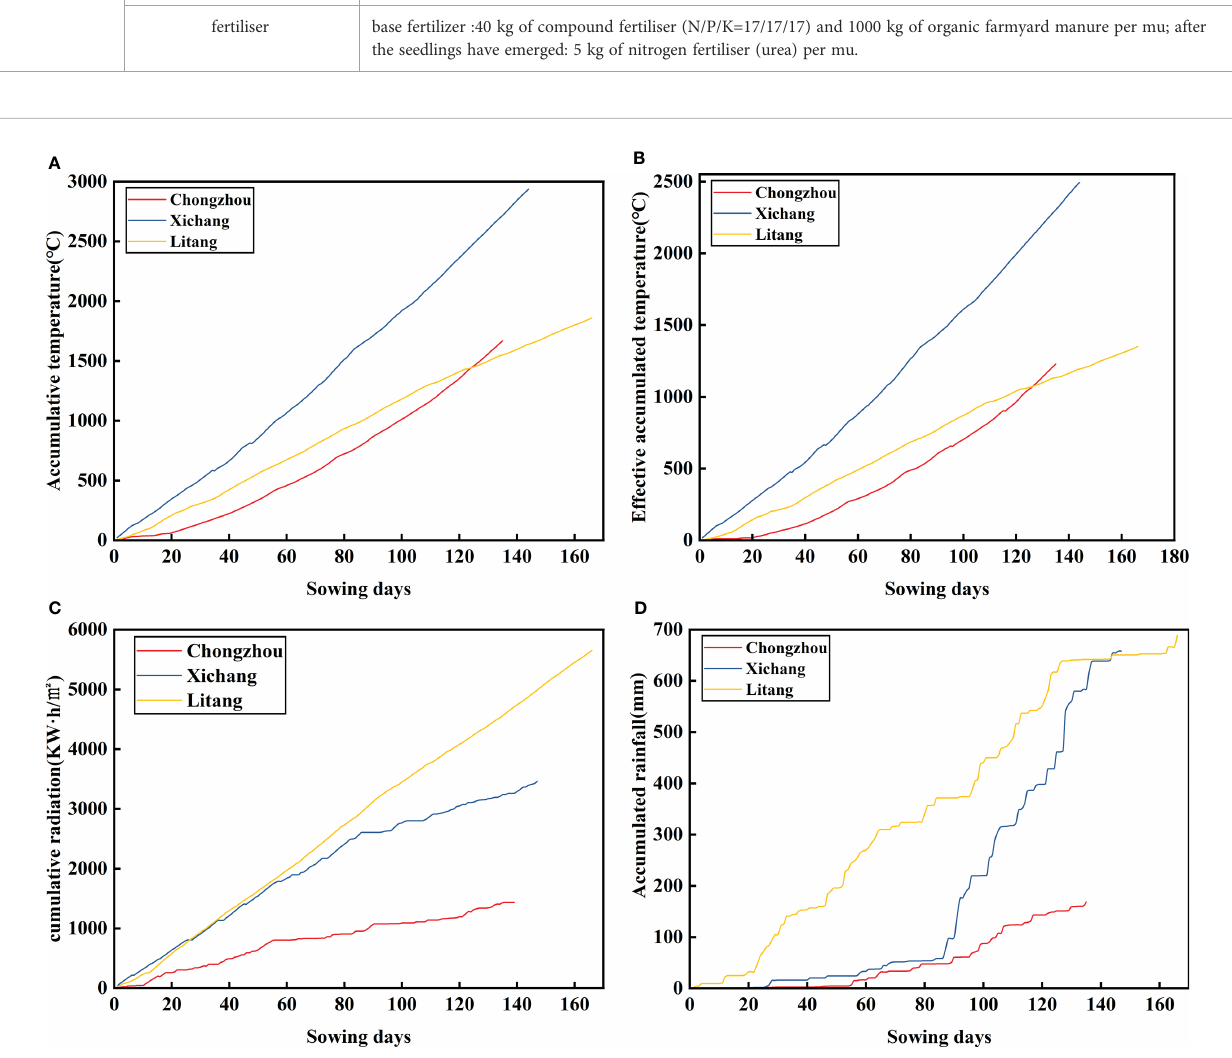
FIGURE 1 Cumulative temperature, cumulative effective accumulated temperature, cumulative radiation and cumulative rainfall in potato growth period at different altitudes. (A – D) respectively represents accumulative temperature, effective accumulated temperature, cumulative radiation and accumulative rainfall in different